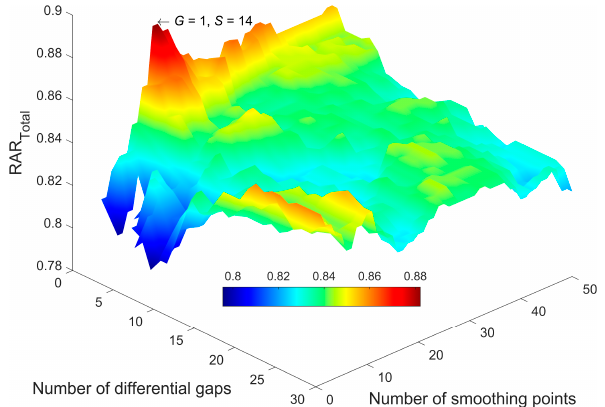
Figure 5. The 3D effect diagram of the modeling discrimination effect of kNN models processed by NDF for the number of smoothing points ( S ) and the number of differential gaps ( G ).